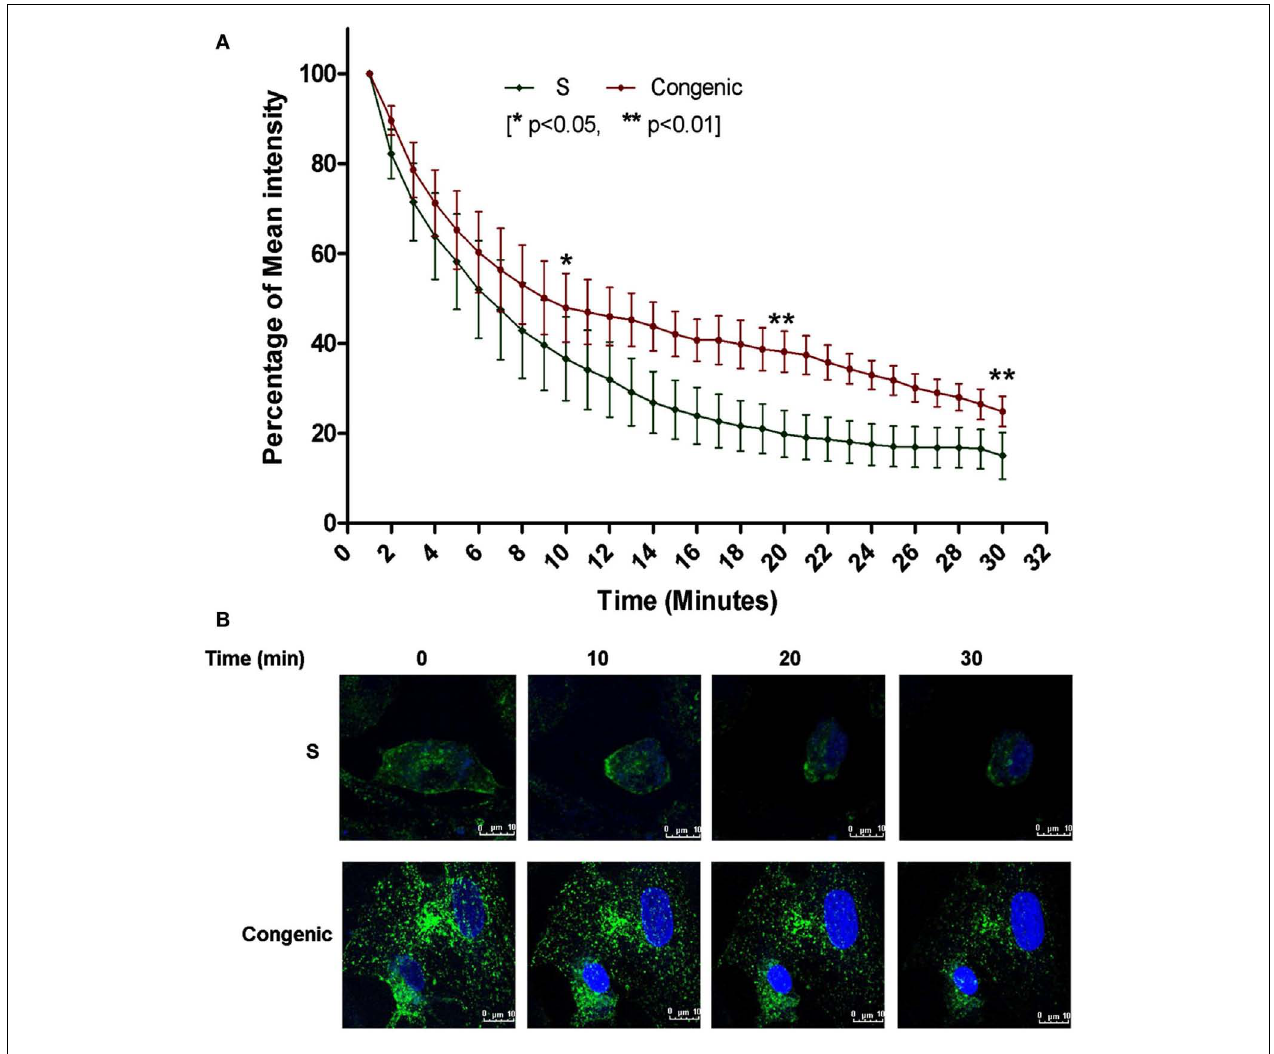
100% in three independent experiments ( n = 3 animals per group) conducted in duplicates (** p < 0.01; * p < 0.05). (B) Representative images, green – fluorescently labeled transferring, blue – DRAQ staining of